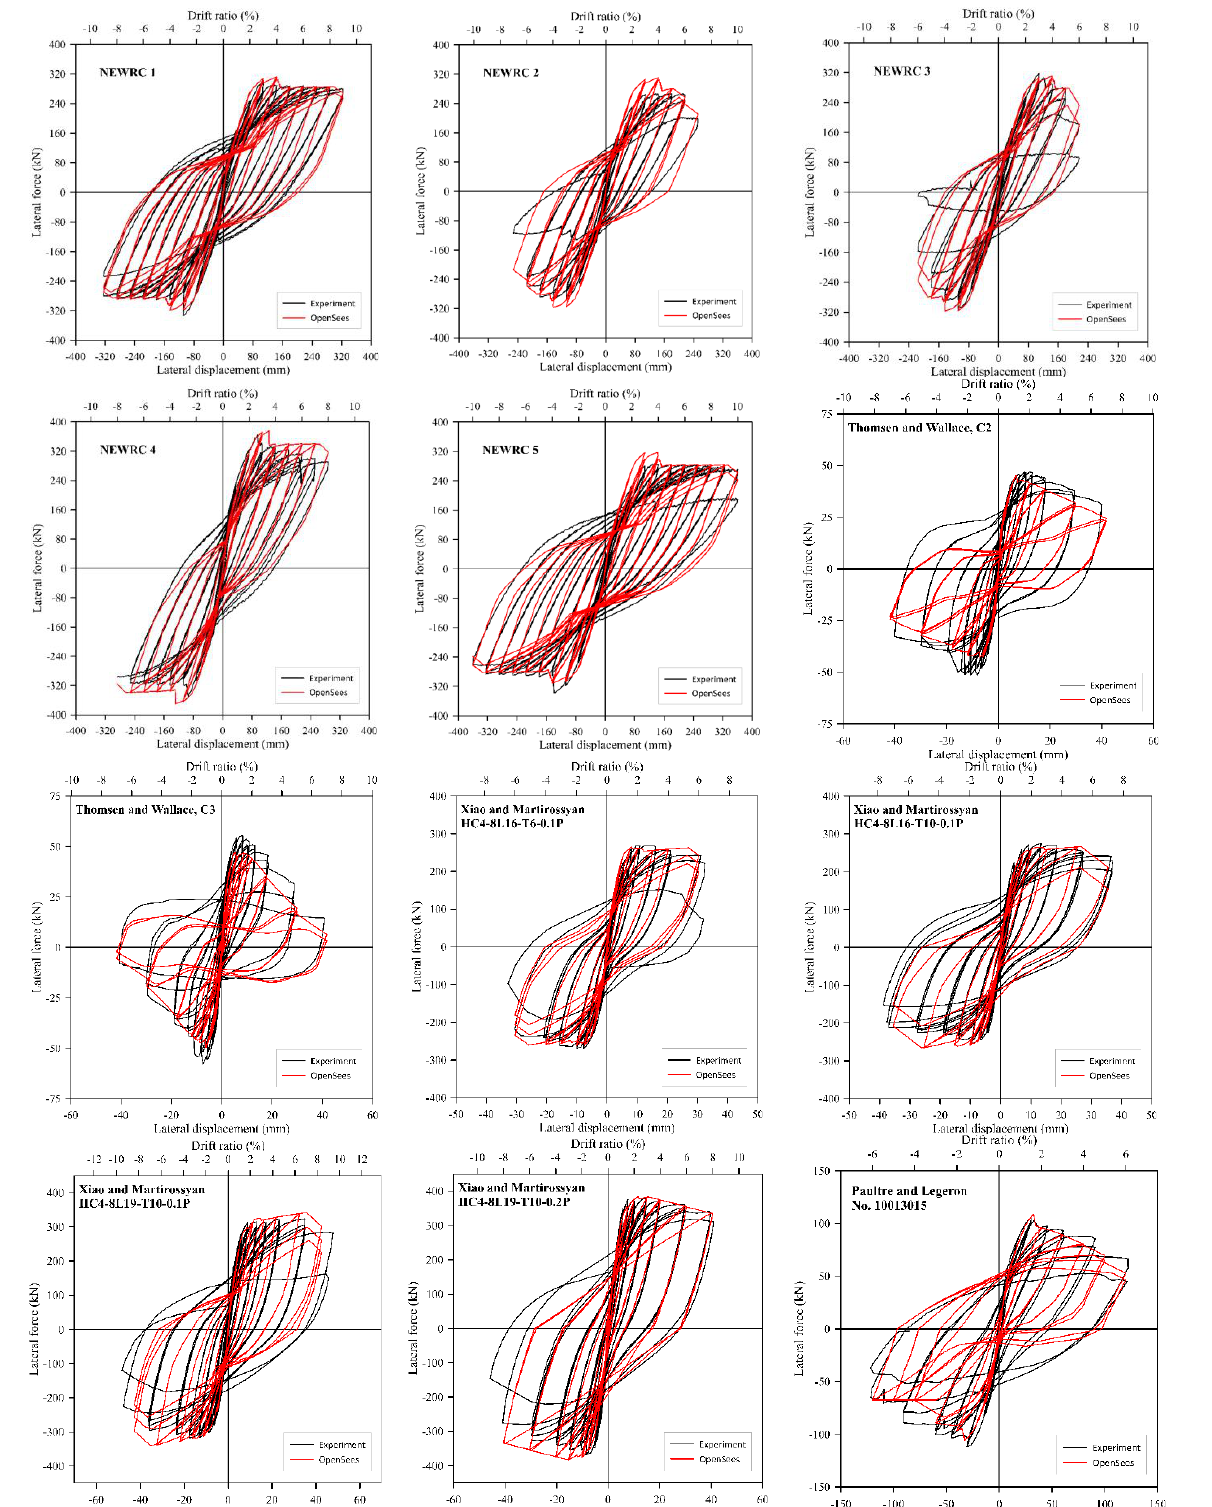
Figure 18. Comparisons of hysteretic curves and backbone curves from numerical simulation and experimental